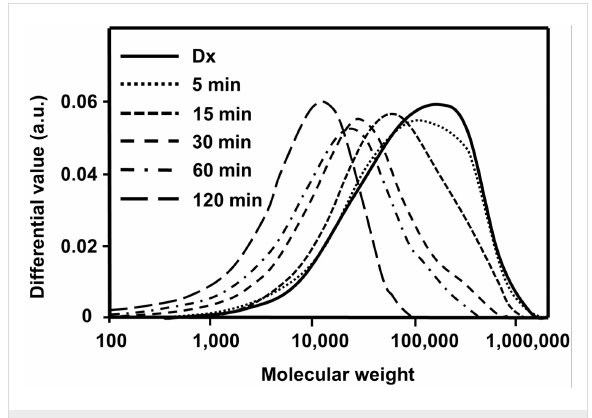
Figure 8: Changes in Dx molecular-weight distribution (MWD) during vibratory milling.